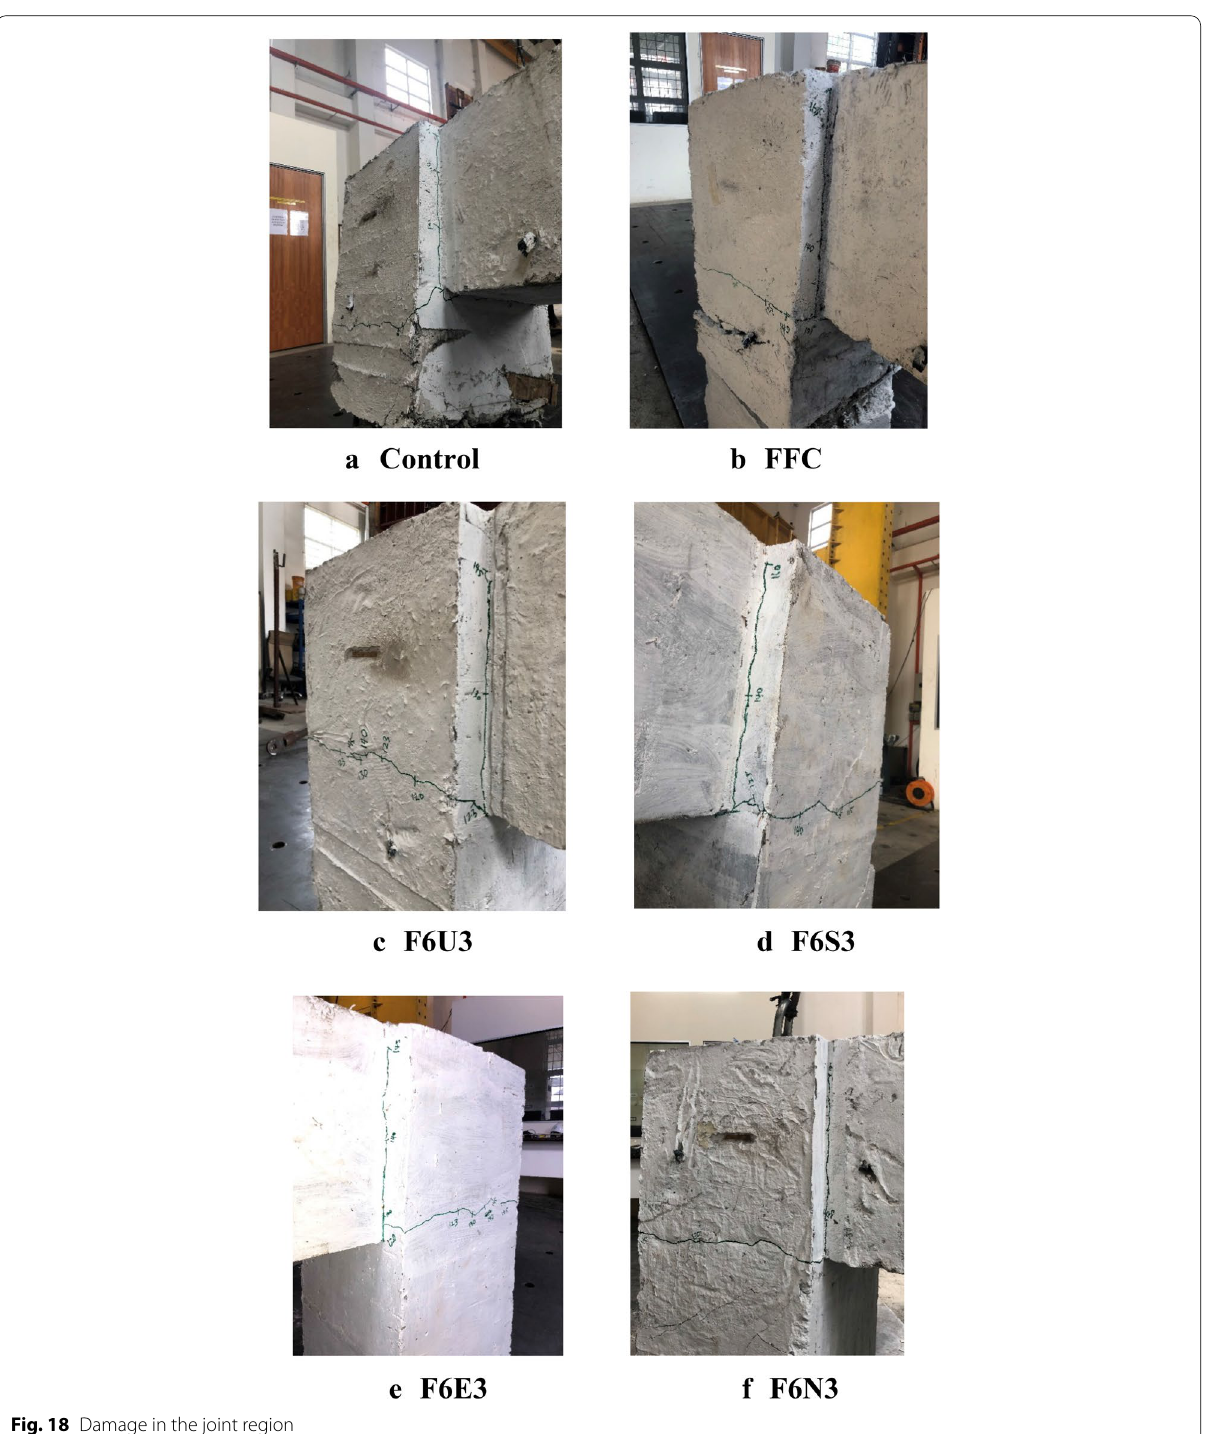
Fig. 18 Damage in the joint